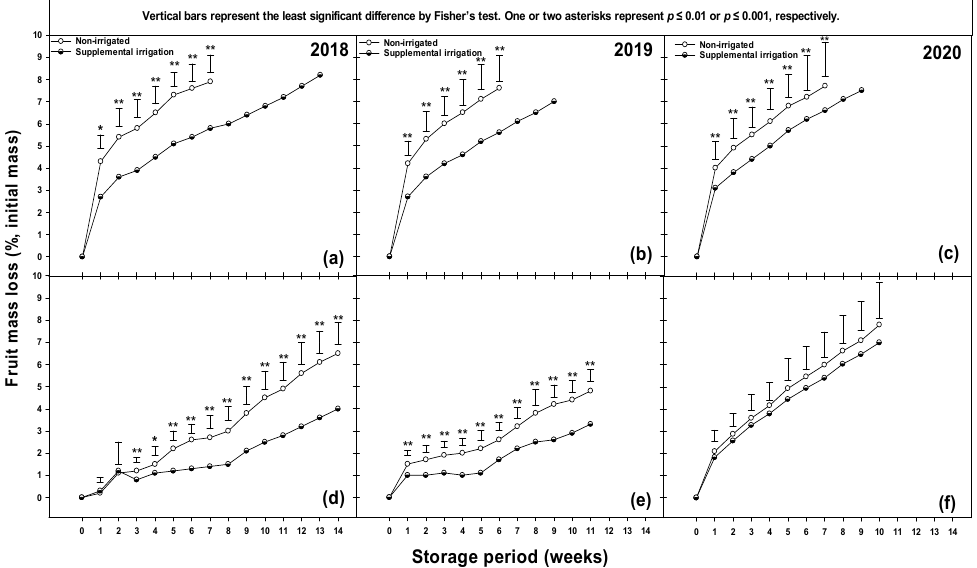
Figure 3. Changes in fruit mass loss of ‘Roja Lisa’ cactus pear, as influenced by supplemental irrigation in three consecutive growing seasons. Fruit were harvested from the commercial orchard ‘Las 100 Hectárias’. La Victoria, Pinos, Zacatecas, Mexico. Table 4. Influence of supplemental irrigation on fruit mass attributes of ‘Roja Lisa’ cactus pear. Fruit were harvested from the commercial orchard ‘Las 100 Hect á rias’. La Victoria, Pinos, Zacatecas,